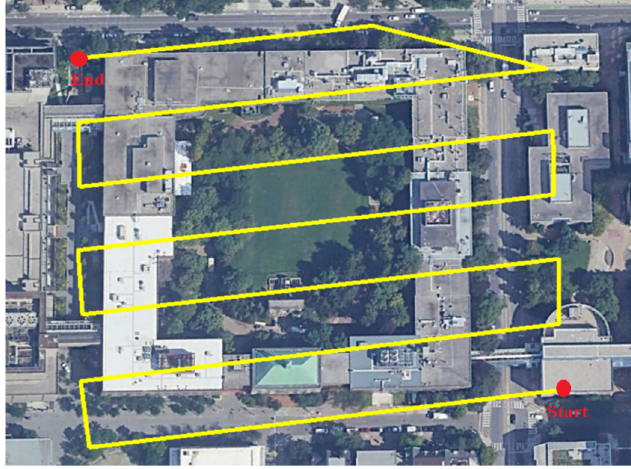
Figure 5. UAS flight lines above the second test site.